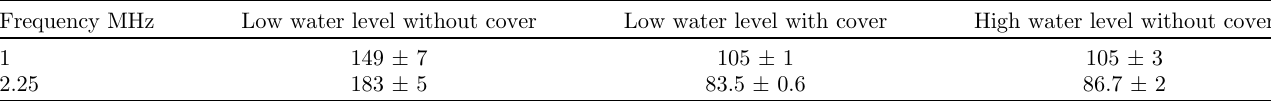
Figure 9. Moduli of the Hilbert transform of the transmitted RF-signals between the 2.25 MHz-transducer and the hydrophone in horizontal position and a low water level above the Petri dish, and the hydrophone in vertical position and a high water level. On the right, the mean values and standard deviations are mentioned. Table 3. Mean peak acoustic pressure measured, p 0